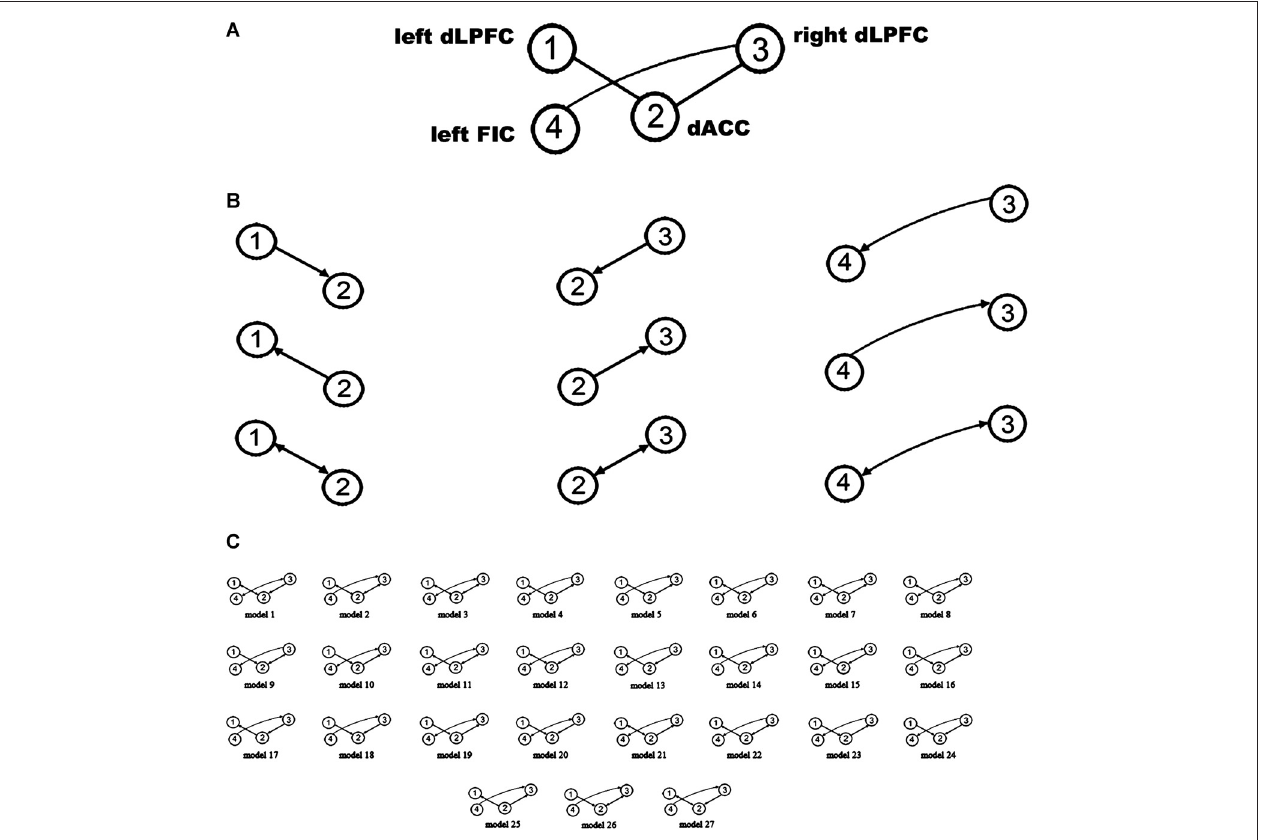
FIGURE 2 | Defining the model space. (A) The basic architecture indicating which connections (black lines) were considered. (B) Possible combinations of effective connections between the bilateral dLPFC, dorsal anterior cingulate cortex (dACC), and left orbital fronto-insular cortex (FIC). (C) The 27 alternative models considered in the bayesian model selection (BMS). The circles indicate the VOIs used in the spDCM